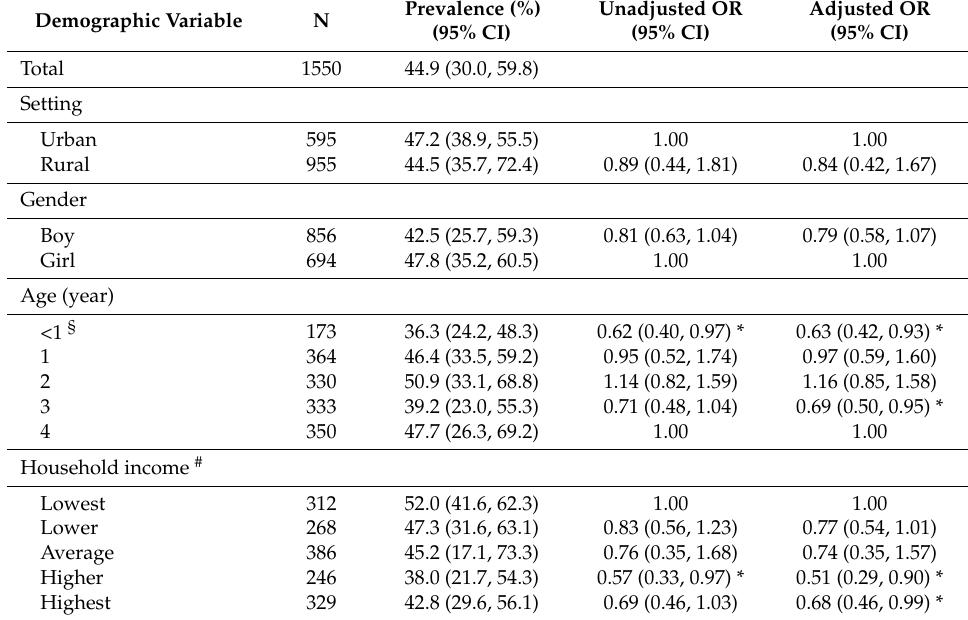
Table 2. Weighted prevalence of having ever been exclusively breastfed at least in the first 6 months of life among children under 5 years of age and associations with demographic factors (Hunan Province of China,